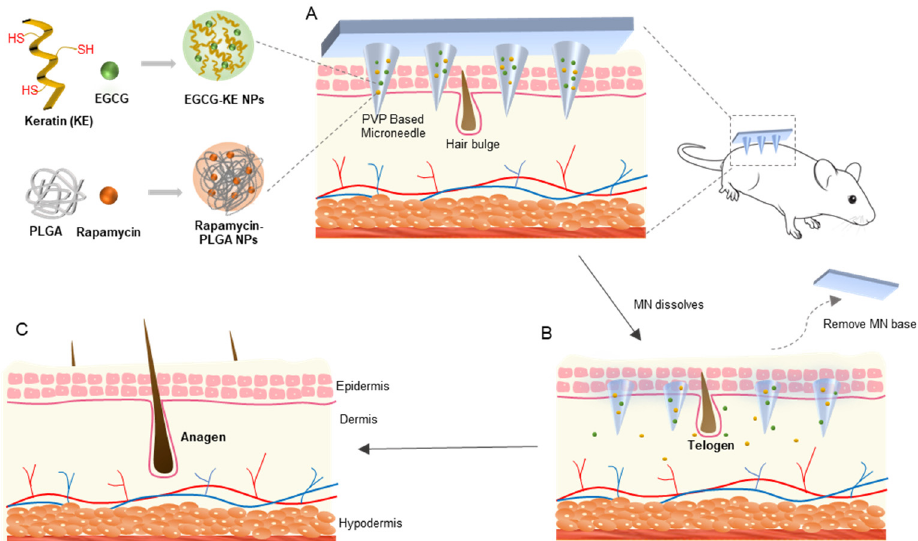
Figure 1. Schematic of the microneedle device for hair regrowth. ( A ) Our DMN (PVP-based mi- croneedle loaded with RAPA-PLGA and EGCG-KE NPs) penetrate the skin. ( B ) The microneedles dissolve rapidly and release nanoparticles and drug transport into the hair follicle niche. ( C ) Drugs can activate the healthy hair cycle, accelerate the transition of hair follicles from telogen to anagen, and promote hair regrowth.